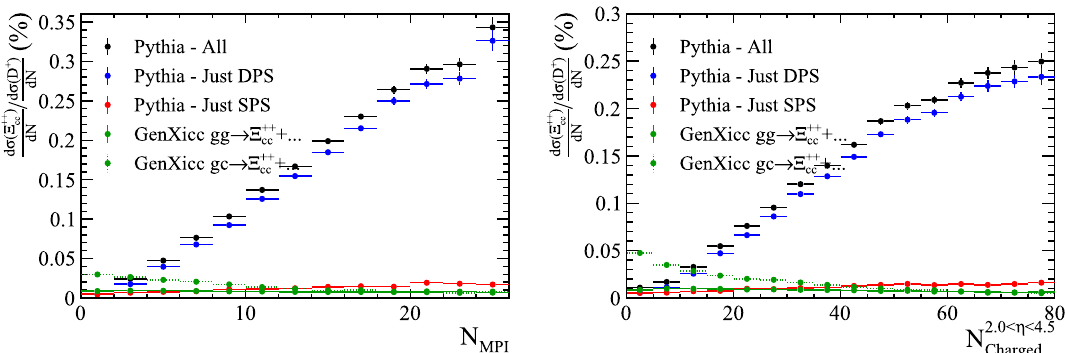
Fig. 13 Ratio of differential cross-section of (cid:2) ++ cc and D + hadrons as a function of (left) the number of parton interactions in a collision and (right) the number of charged particles within the pseudo-rapidity region 2 . 0 < η < 4 . 5, as generated with GenXicc and Pythia